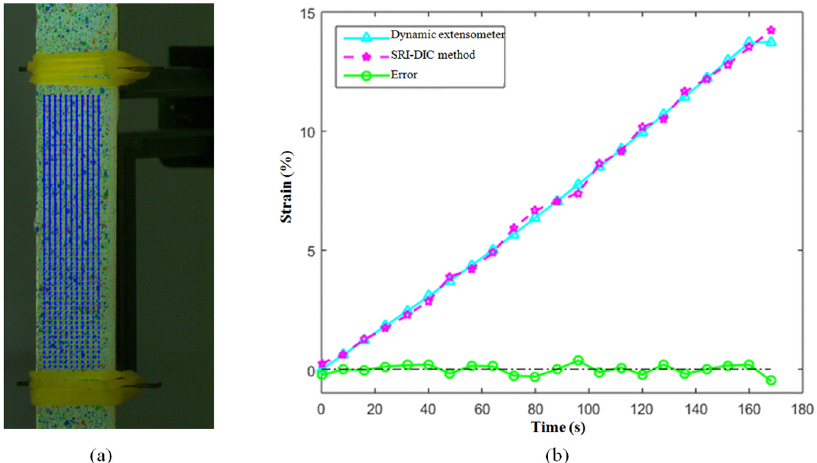
Figure 10. The measurement results of uniaxial tensile test; ( a ) the displacement vector diagrams of various seed points in X and Y directions; ( b ) comparison results of strain values measured by dynamic extensometer and SRI-DIC algorithm.